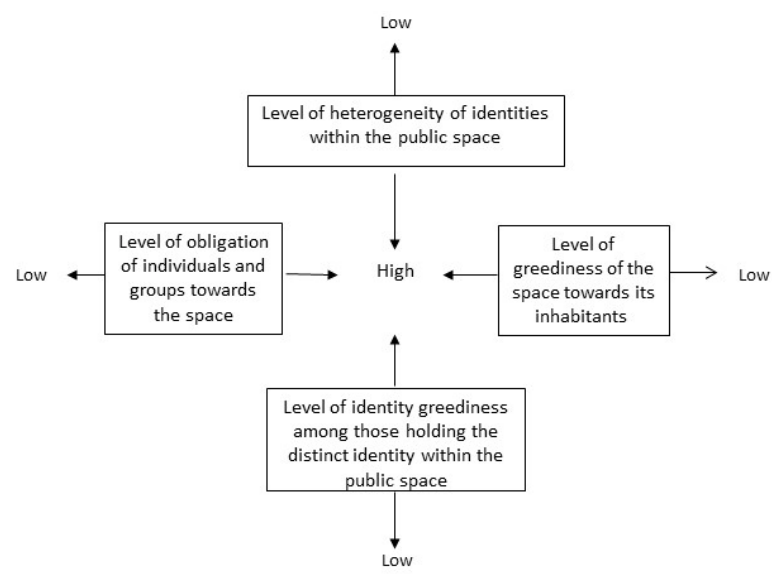
Figure 1. The Confrontation Model.